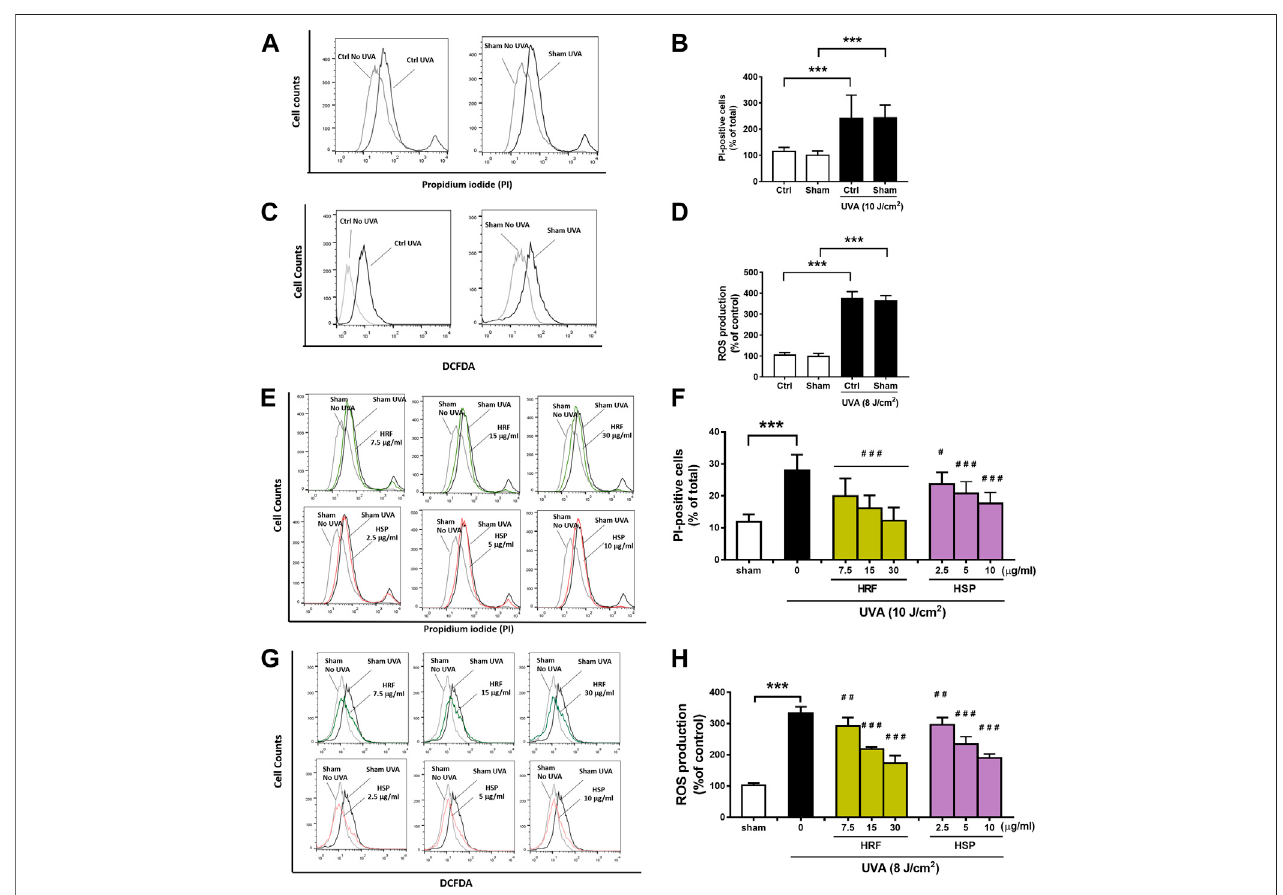
FIGURE 1 | The protective effects of HRF and its active ingredient HSP on UVA-induced cytotoxicity and oxidative stress in NHDFs. HRF at dose 7.5, 15, and 30 μ g/ml and HSP at dose 2.5, 5, and 10 μ g/ml as well as the ethanol treatment and no compound treatment (0), were individually treated in NHDFs prior to UVA (10 J/cm 2 ) irradiation for cytotoxicity assay. Treated cells were harvested at 12 h post-irradiation to perform the fl ow cytometry of fl uorescent staining, propidium iodide (PI), for the PI-positive cells (% of total). The fl ow histogram (A) and summary graph analysis (B) of ethanol sham treatment and compare to UVA irradiated cells and the histogram (E) and summary graph analysis of treatment groups (F) . The HRF and HSP were individually treated in NHDFs prior to UVA (8 J/ cm 2 ) irradiation. Treated cells were harvested at 1 h post-irradiation to perform the fl ow cytometry of fl uorescent staining, DCFDA dye, for the evaluation of the ROS production(%ofcontrol).The fl owhistogram (C) andsummarygraphanalysis (D) ofethanolshamtreatmentand comparetoUVAirradiatedcellsandthehistogram were expressed as mean ± SD, n (cid:1) 4. *** p < 0.001 vs. non-irradiated sham group by Student ’ s t -test. #p < 0.05; ## p < 0.01; ### p < 0.001 vs. the sham-irradiated group by one-way ANOVA Dunnett ’ s